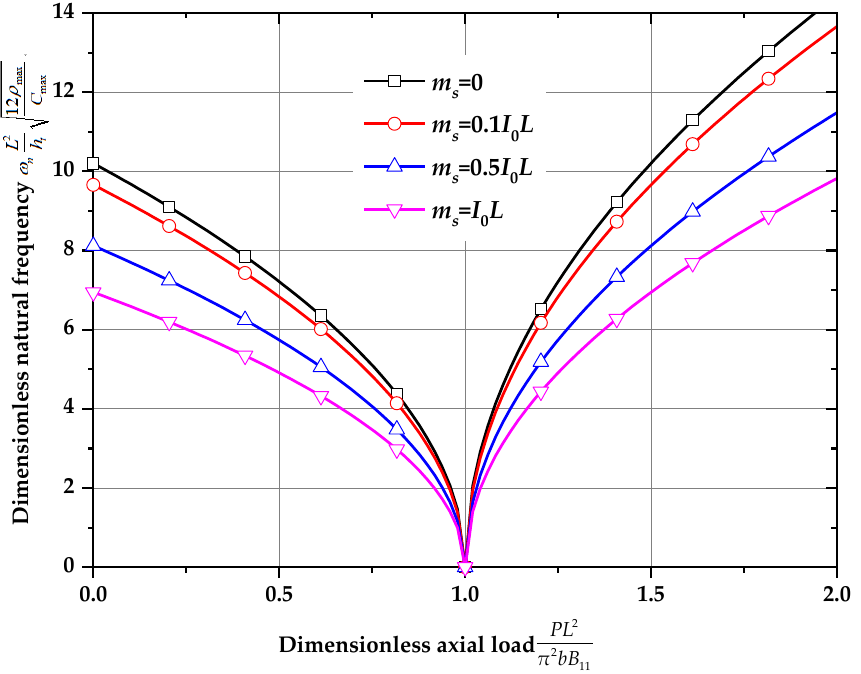
Figure 4. Variation of the dimensionless natural frequency ( dimensionless axial load ( PL 2 / ( π 2 bB 11 ) ) compared with Ref. [71].